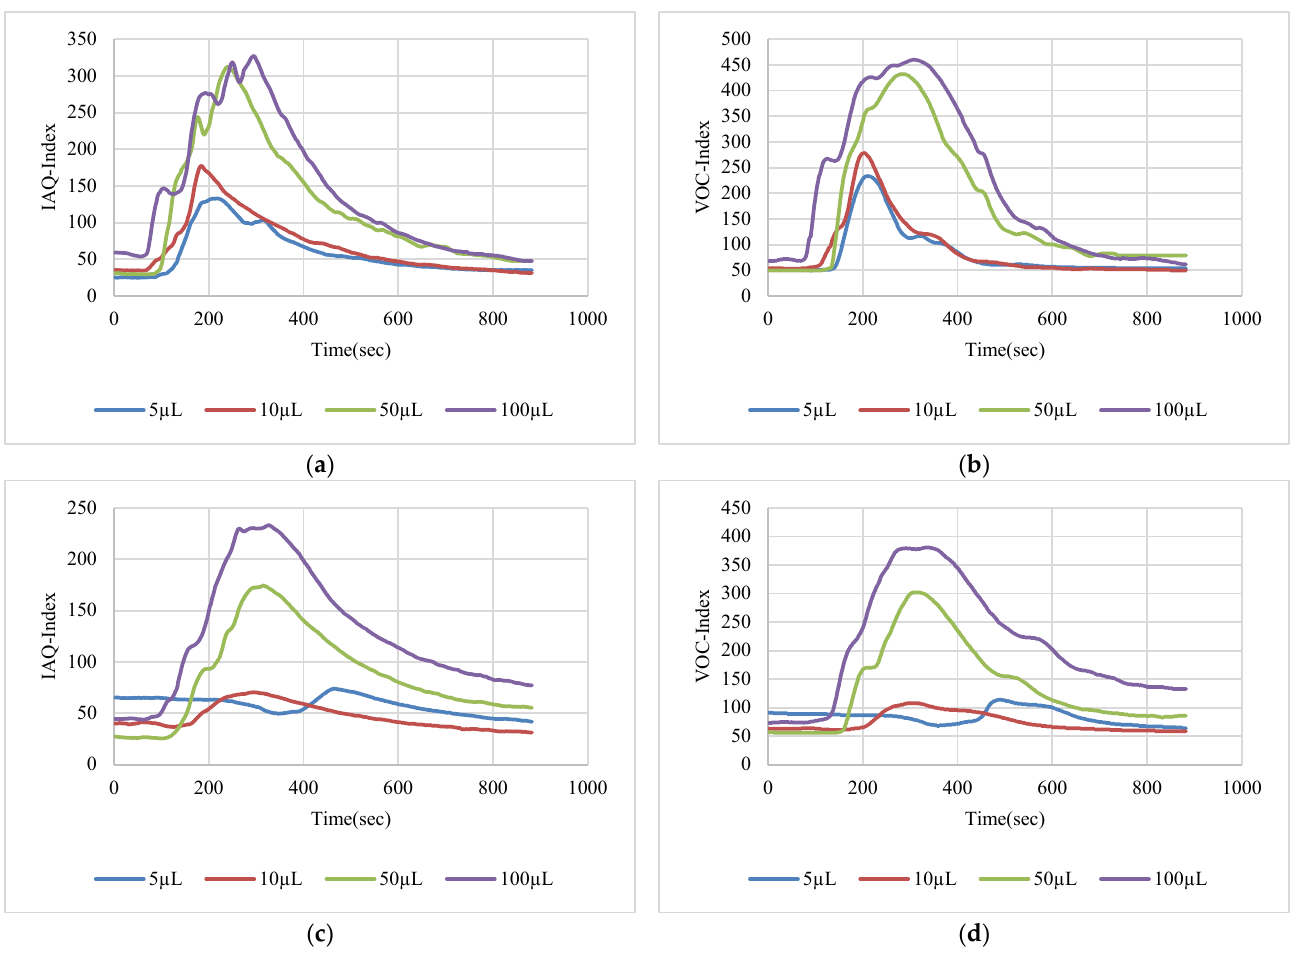
Figure 18. Test results for isopropanol: ( a ) BME688 40 cm, ( b ) SGP41 40 cm, ( c ) BME688 100 cm, ( d ) SGP41 100 cm.